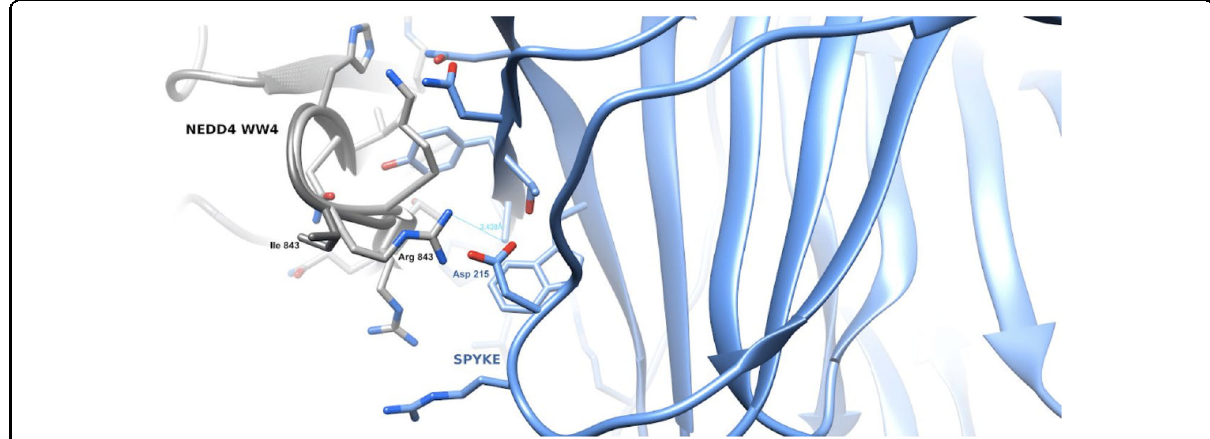
Fig. 5 Gain-of-Function mutants in NEDD4, but not SMURF1 and WWP1, display elevated interaction with, but comparable ubiquitination of the SARS-CoV-2 S protein. A , C IB of fl ag-immunoprecipates and WCL derived from HEK293T cells that were transfected with HA-SARS-CoV-2 S and NEDD4/WWP1 WT and mutants. B , D IB of Ni-NTA pulldown and WCL derived from HEK293T cells that were transfected with SARS-CoV-2 S and NEDD4/WWP1 WT and mutants. E IB of fl ag-immunoprecipates and WCL derived from HEK293T cells that were transfected with HA-SARS-CoV-2 S and WT and mutants for Smurf1 or WWP1. F IB of Ni-NTA pulldown and WCL derived from HEK293T cells that were transfected with SARS-CoV-2 S and WT and mutants for Smurf1 or WWP1. G Binding and ubiquitination activity in WWP1/NEDD4/SMURF1 mutants vs. wild-type